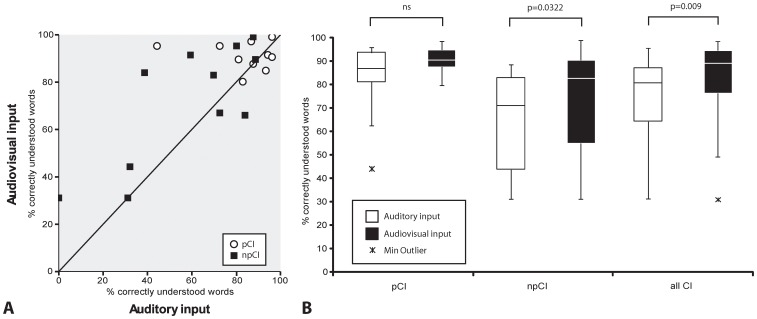
CI-users and audio-visual gain for Skype™ transmission.A. Speech perception scores of n = 10 proficient (pCI) and n = 11 non-proficient (npCI) CI users for exclusive auditory input vs. audio-visual input. B. Non-proficient CI users and the two groups combined (all CI) showed a statistically significant audio-visual gain (Boxplots). Proficient CI users showed a non-significant trend for AV-gain.